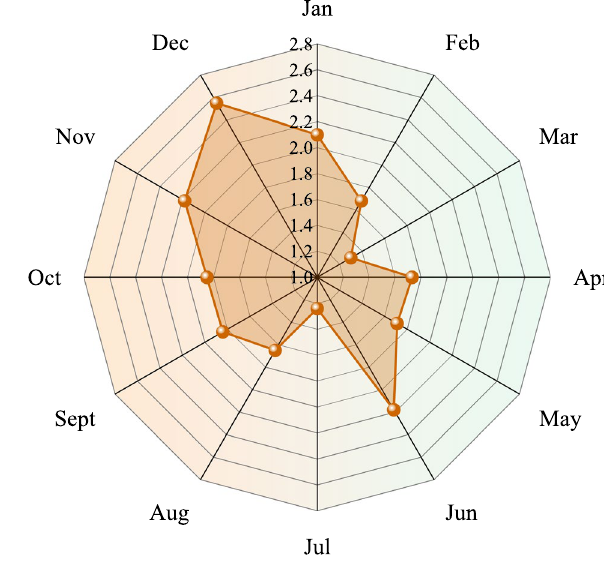
Fig. 11 Death tolls in different months from 2017 to 2021